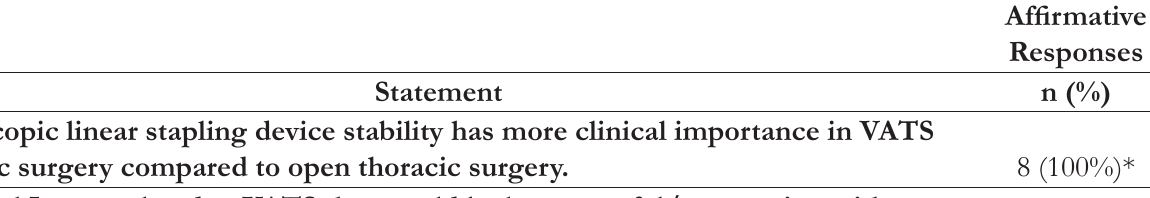
Table 5. Survey 2: Results on Device Stability in VATS and Open Thoracic Surgery